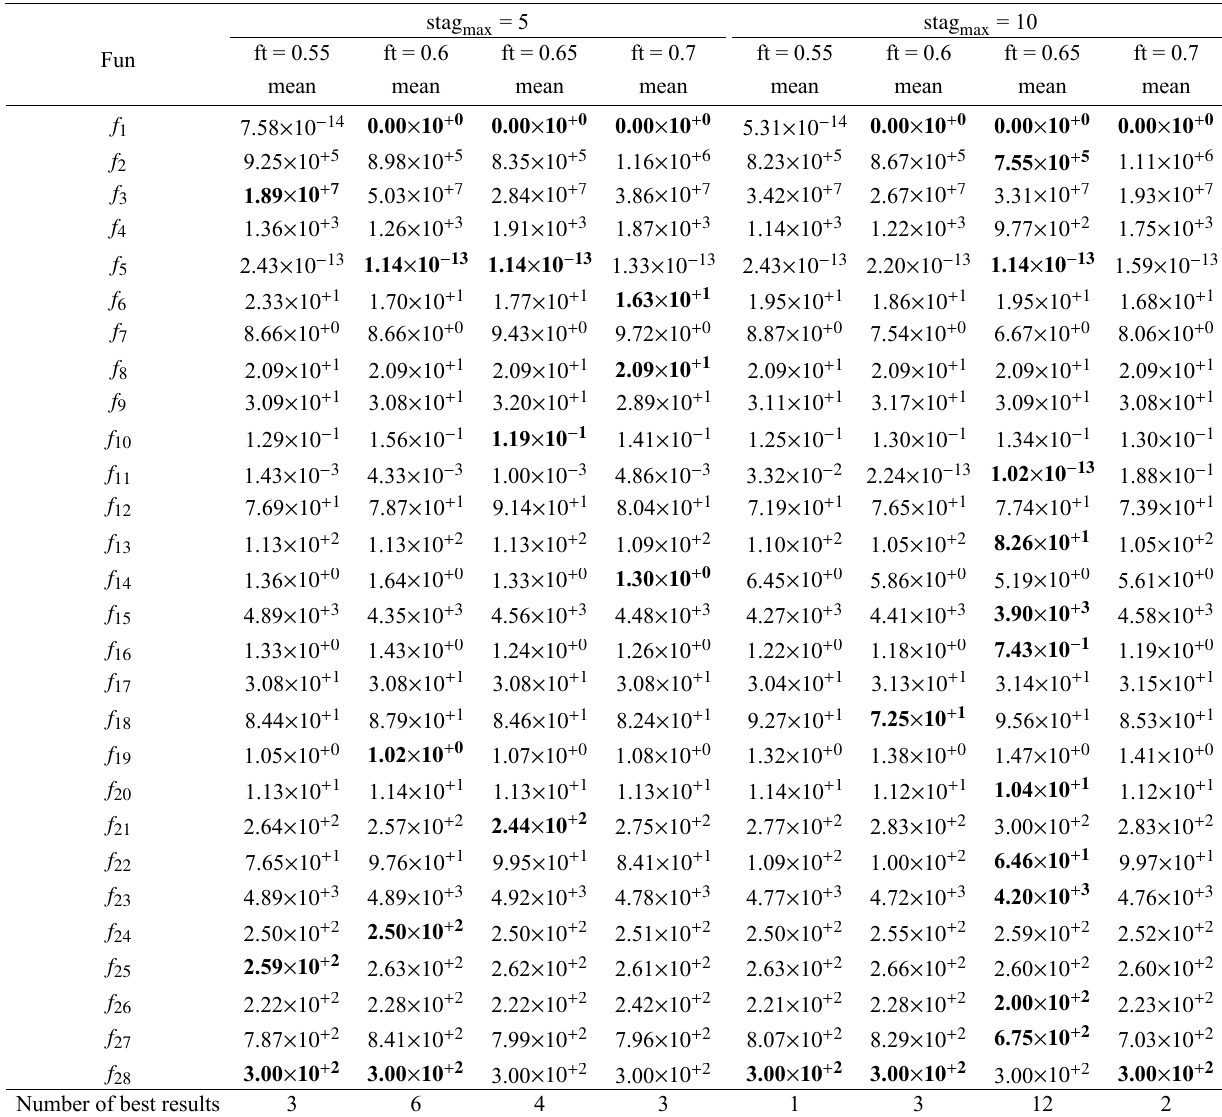
Table A1 and A2: Parameters and (cid:15) Table A3: Comparison results ( D = 30). (cid:15) Table A4: Comparison results ( D =